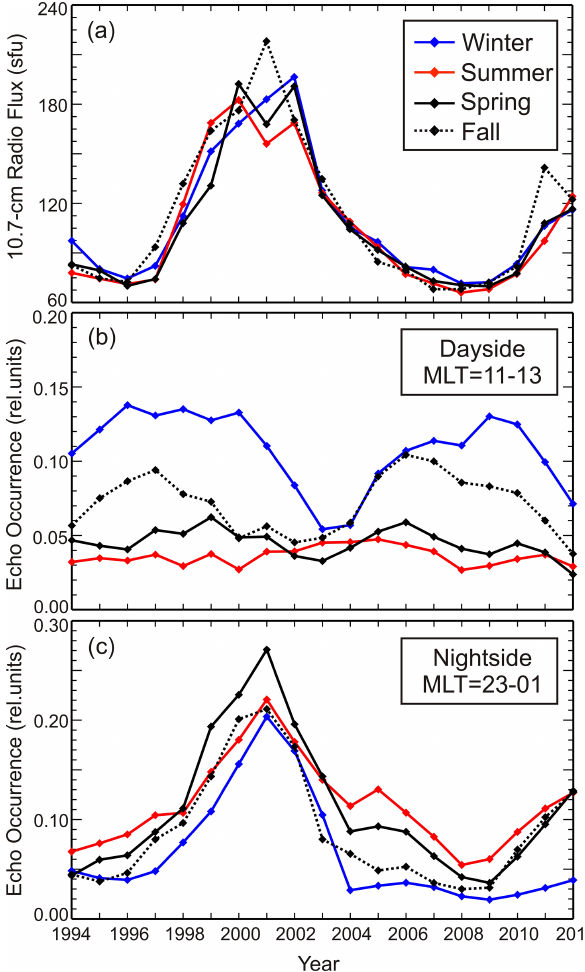
Fig. 4. Season-averaged (a) 10.7cm radio flux; (b) SAS radar